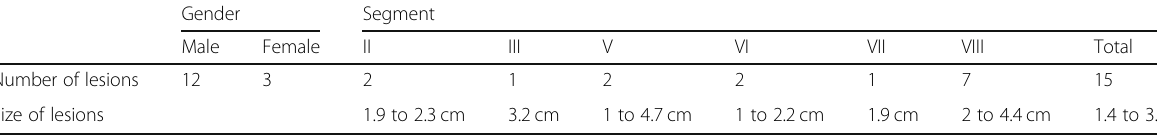
Table 1 Distribution frequency of the hepatic focal lesions according to gender and liver segment